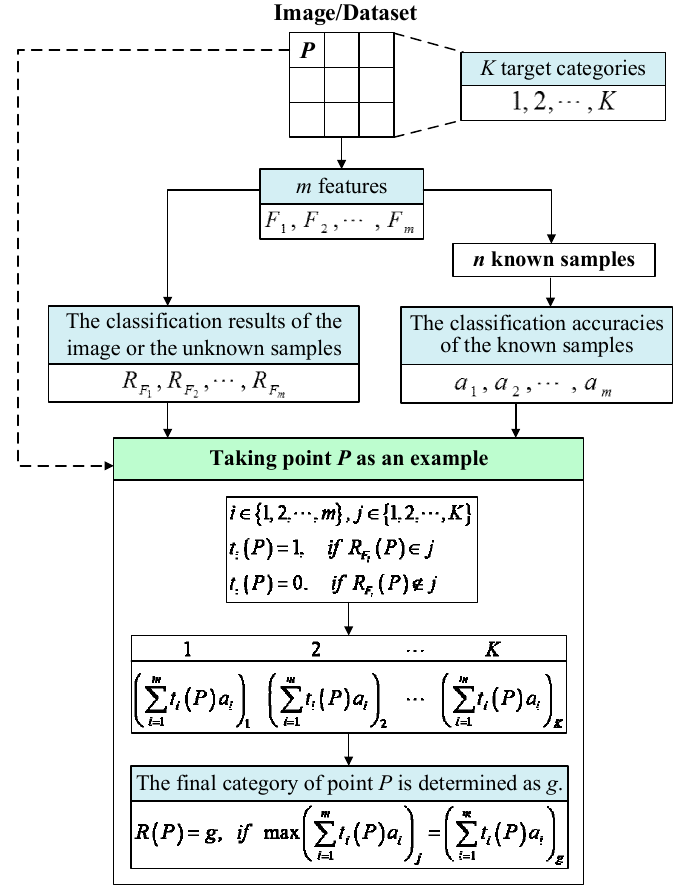
Figure 1. Schematic diagram of the precision-weighted multi-feature fusion (PWMF) method.